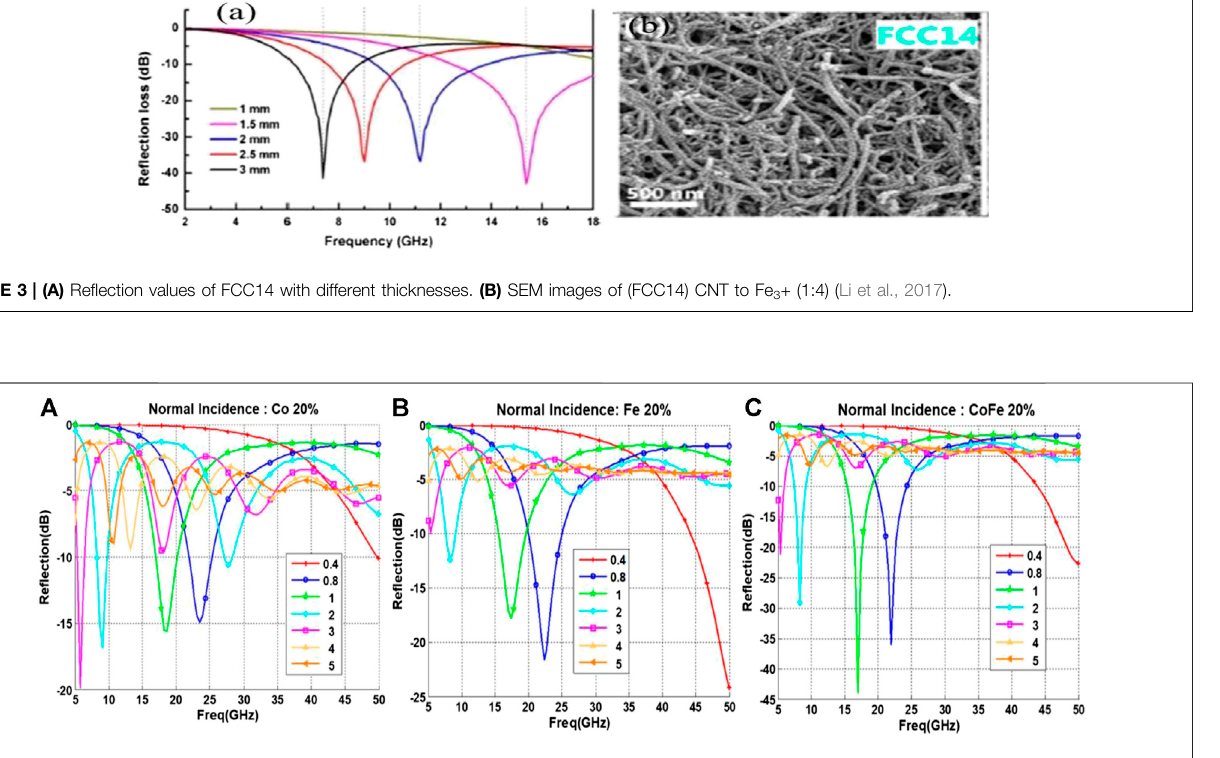
FIGURE 4 | Re fl ection loss for PU with 5% CNT with 20 wt% (A) Co, (B) Fe, and (C) CoFe for different thicknesses (Hussein et al., 2020).